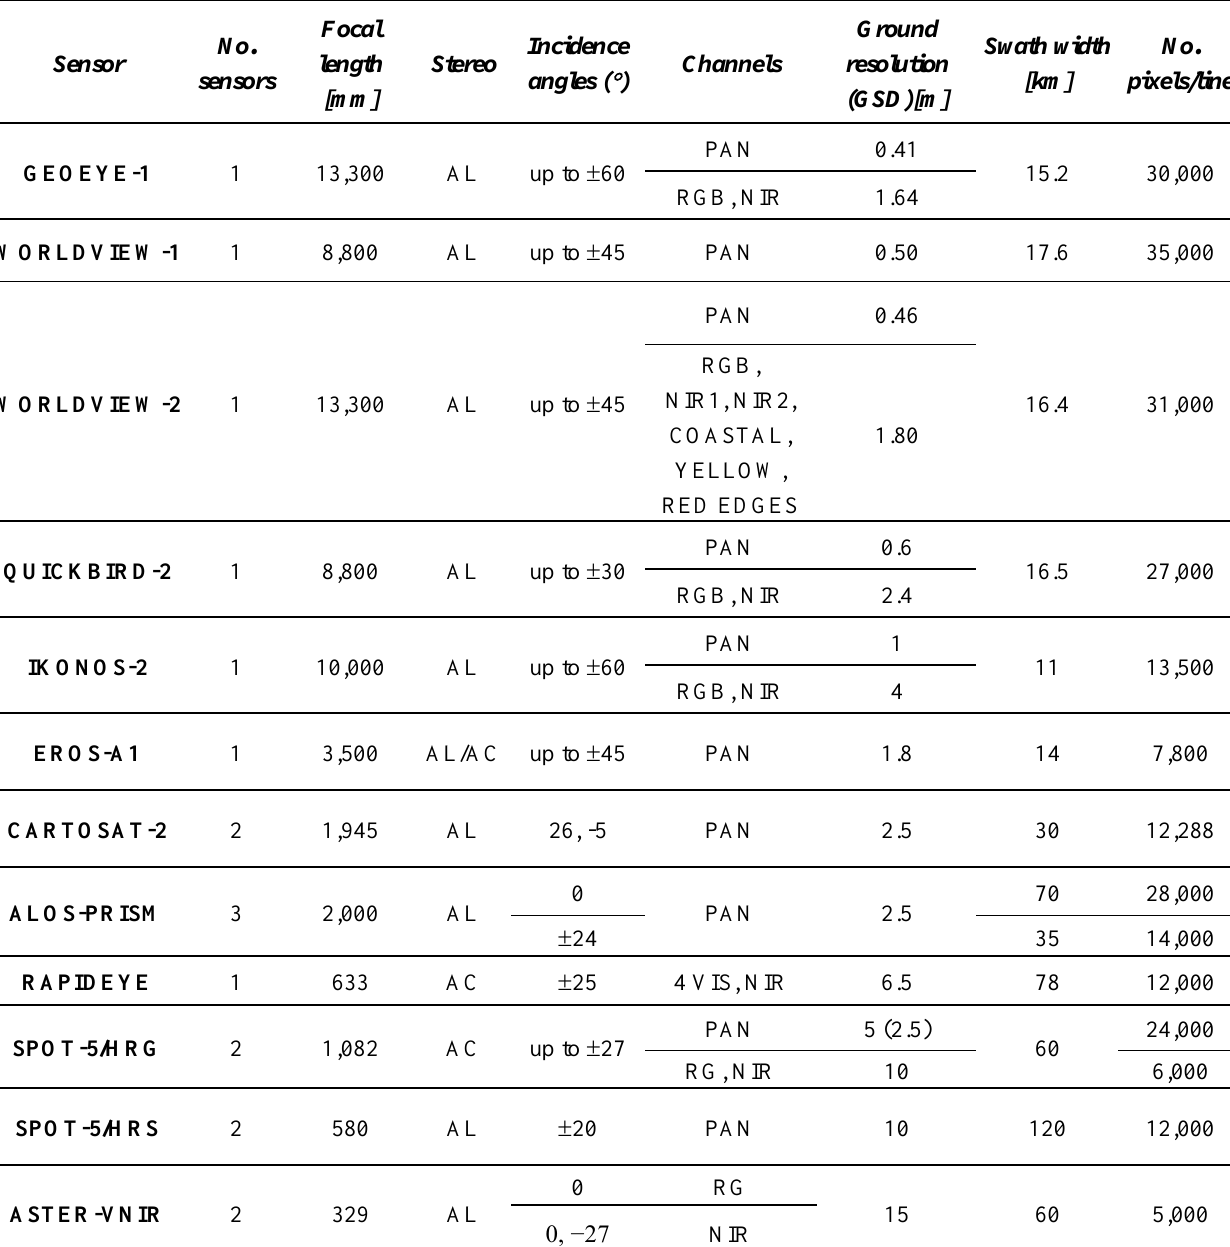
Table 7. High resolution (<15 m) optical satellite sensors (AL = along-track; AC = across-track). Sensor